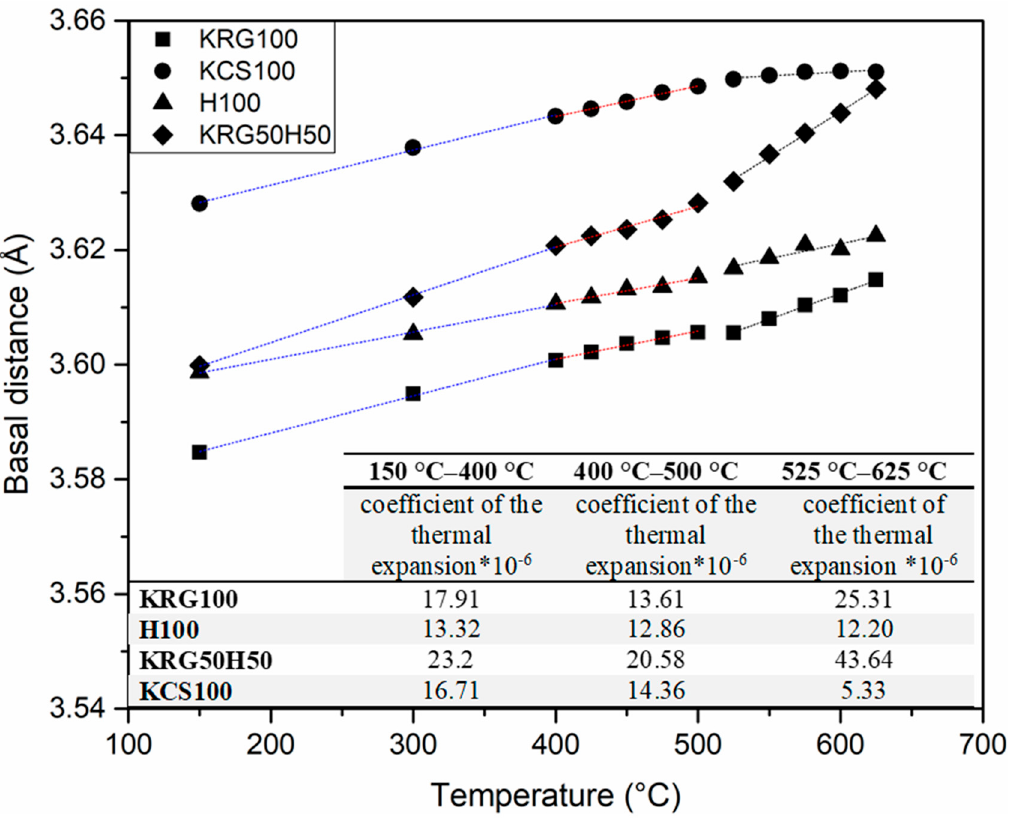
Figure 9. The variation of the basal spacing (002) and calculated coefficient of the thermal expansion of KCS100, KRG100, H100, and KRG50H50 during dehydroxylation.